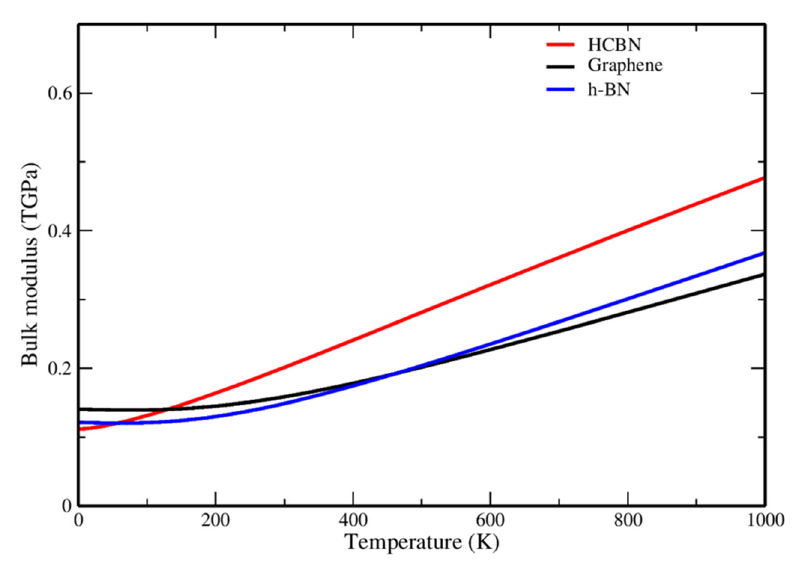
Figure 9. Temperature-dependent bulk moduli of HCBN (red curve), graphene (black curve), and h-BN (blue curve).